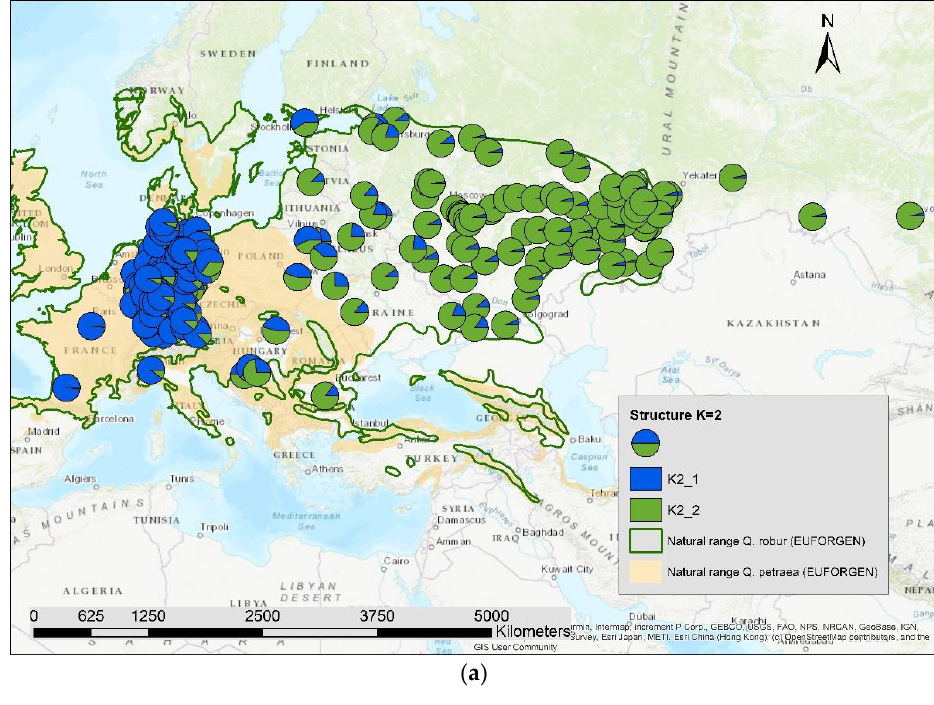
Figure 4. Delta K values for the results of the analysis with STRUCTURE.